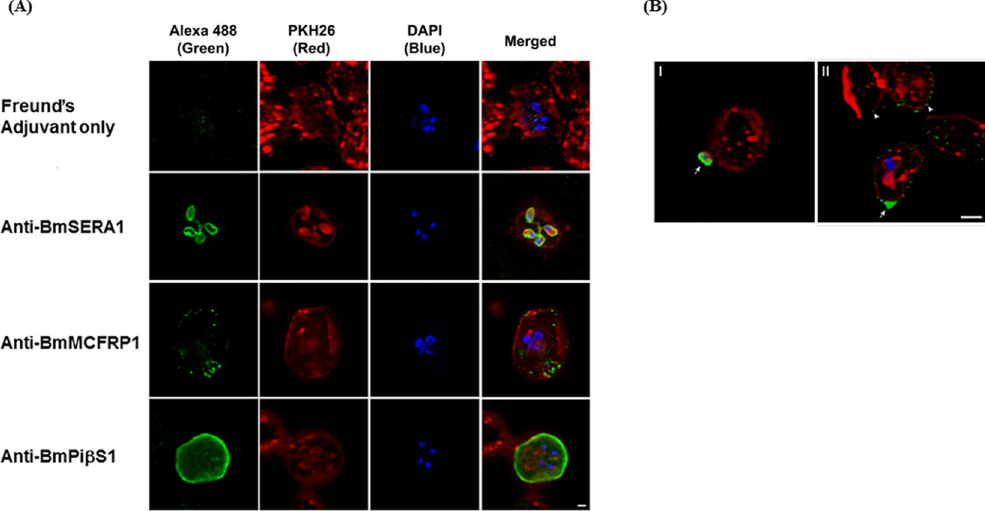
Figure 5. ( A ) The fluorescent image shows localization of BmSERA1, BmMCFRP1 and BmPi β S1 in B. microti infected mouse red blood cells (see results). Green channel (Alexa 488) images correspond to the location of B. microti parasite proteins. Red channel images are cell membrane stained by PKH26 and Blue channel shows DAPI stained nuclei. Merged images contain the overlay of green, red and blue channels. As observed, sera from mice immunized with Freund’s adjuvant only (negative control) shows DAPI stained nuclei demonstrating B. microti infected RBCs without a traceable green signal, confirming specificity of the assay. Sera collected from mice immunized with BmSERA1, BmMCFRP1 and BmPi β S1 in Freund’s Complete Adjuvant show specific localization of the B. microti proteins as membrane bound on the parasite surface (anti-BmSERA1) or on the surface of infected RBCs (anti-BmMCFRP1 and anti-BmPi β S1). Scale bar indicates 1 µ m. ( B ) I. Free B. microti merozoite located near the uninfected RBC expressed BmMCFRP1 (arrow, green). Note that plasma membrane of B. microti and RBC were stained by PKH26 dye (red). Counterstaining by DAPI indicates B. microti nuclei (blue). II . The B. microti merozoite found inside RBCs showed negative staining for anti-BmMCFRP1. The apical region (entry site) of RBCs showed strong positive staining for BmMCFRP1 (arrow, green). In addition, the surface of infected and surrounding uninfected RBCs showed punctate pattern of BmMCFRP1 (arrowheads). Scale bar indicates 2 μ